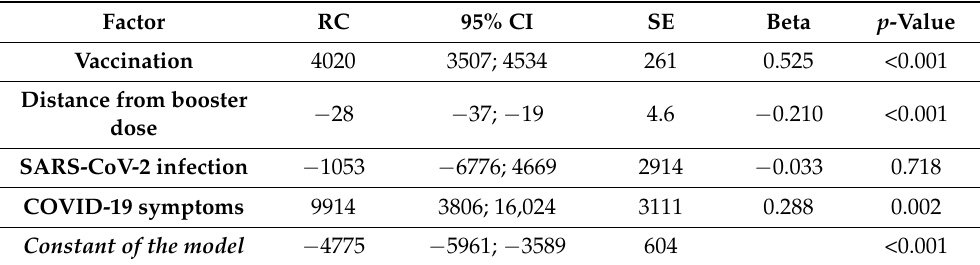
Table 5. Multivariate analysis of the factors influencing “anti SARS-CoV-2 antibody titer”. Vaccine types have been numbered from 1 to 5 based on the median antibody titer (Table 4). RC: regression co- efficient; SE: standard error; Beta: beta coefficient. Durbin–Watson parameter is equal to 1.9 indicating absence of autocorrelation in the residuals due to the model.